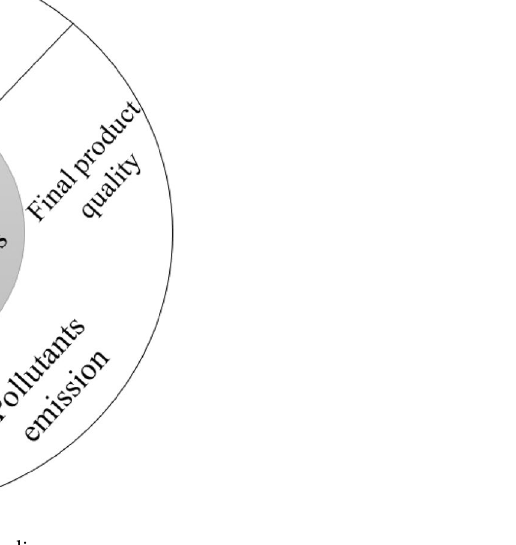
Figure 4. Methods and challenges on CB